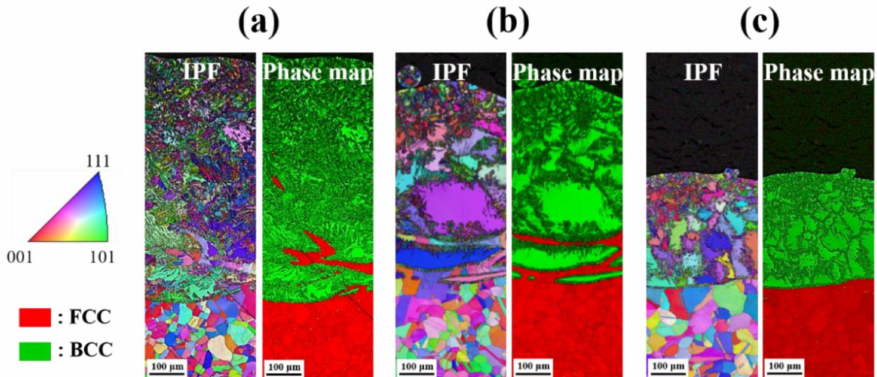
Figure 6. Phase transformation behavior of Fe-Cr-Si single-line clads at various laser traverse speeds: ( a ) 12 mm/s, ( b ) 14 mm/s, and ( c ) 16